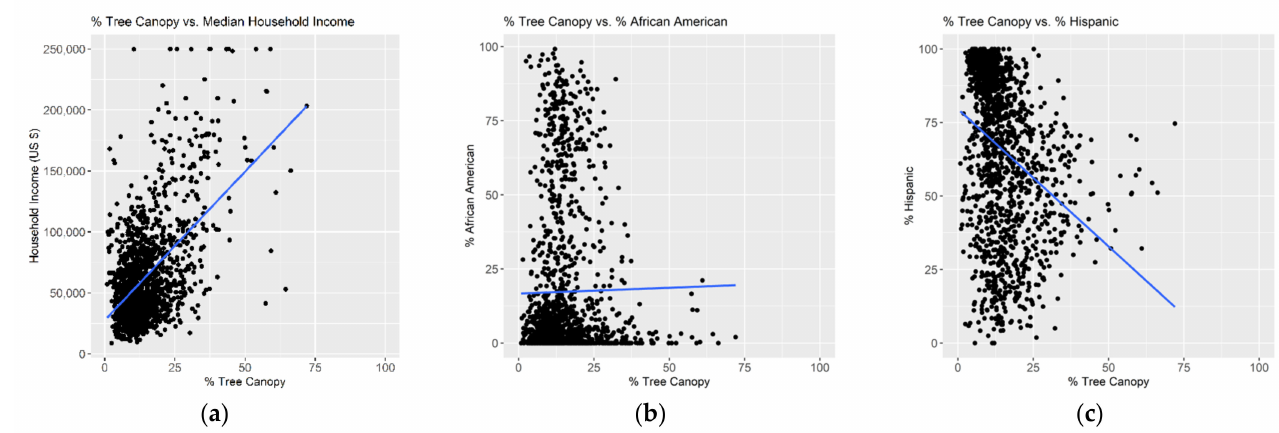
Figure 8. Scatter plots for 2019 socioeconomic data at the census block group level: ( a ) % EUTC vs. Annual Household Income, ( b ) % EUTC vs. % African American population, and ( c ) % EUTC vs. % Hispanic